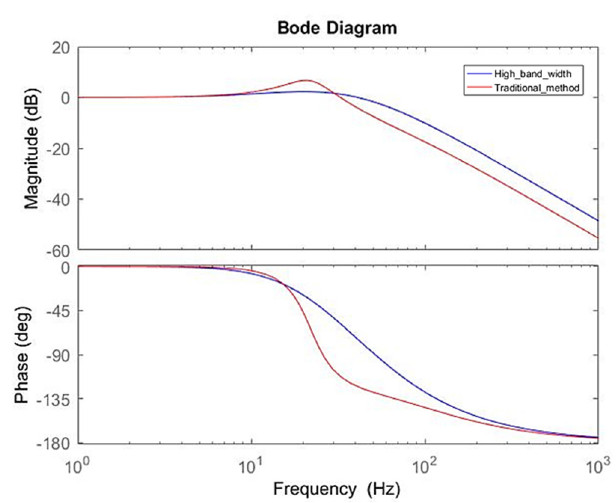
Figure 13. Bode diagram of speed loop. Sensors 2020 , 20 , x FOR PEER REVIEW